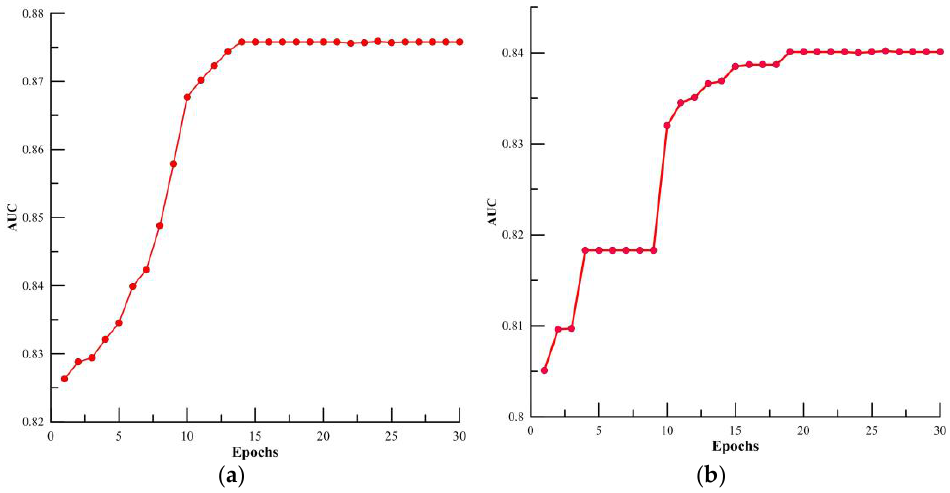
Figure 12. Curves of AUC value: ( a ) bat algorithm one-class support vector machine (BA-OCSVM); ( b ) firefly algorithm one-class support vector machine (FA-OCSVM).